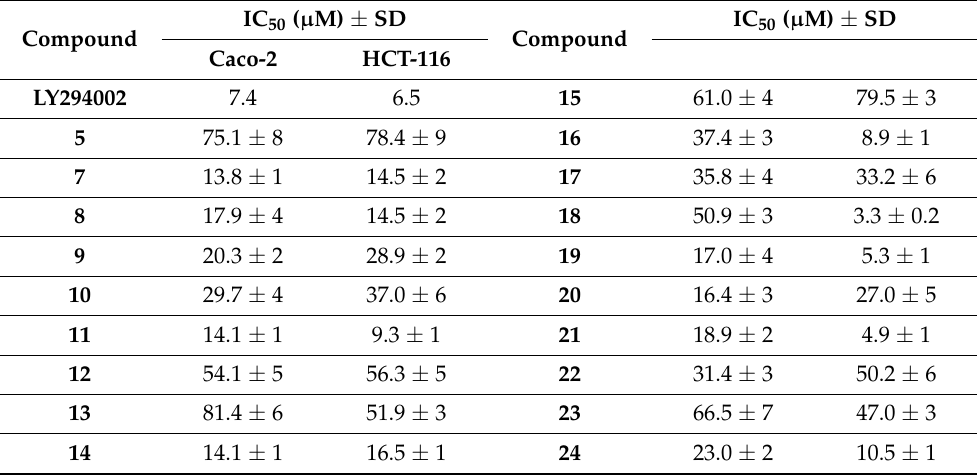
Table 2. Inhibitory activity (IC 50 µ M) of 5 , 7–24 .